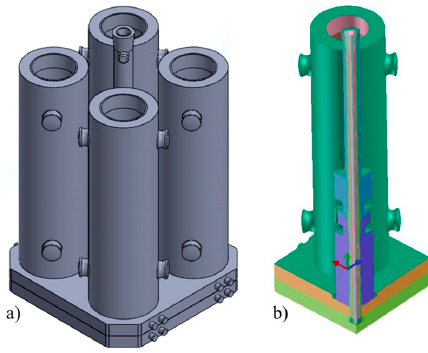
Figure 2. Geometry of the four-mold gating system ( a ); and used model ( b ).